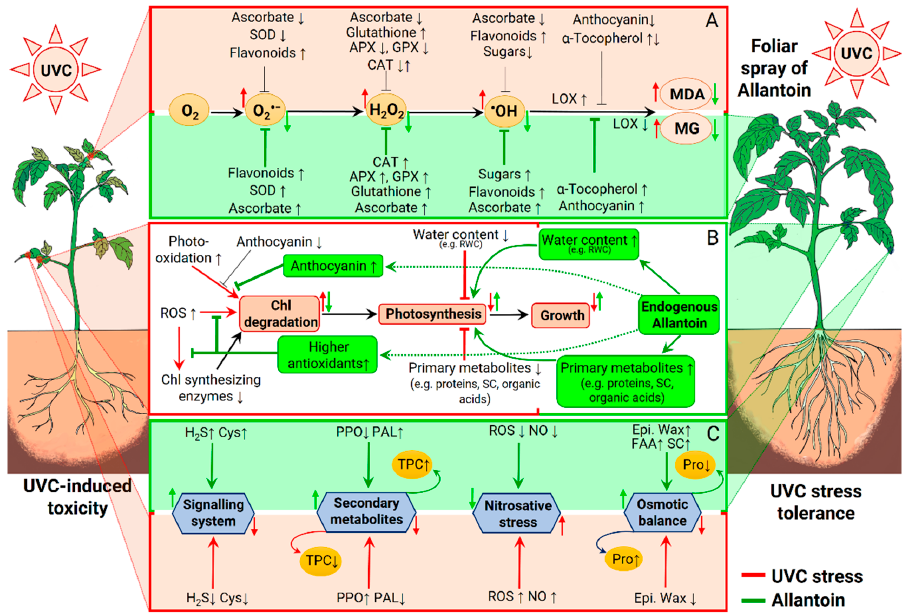
Figure 7. Particularly, AT-induced UVC stress tolerance could be attributed to (i) improve- ment of plant water retention via regulation of osmolytes, (ii) protection of photosynthetic pigments, (iii) efficient activity of enzymatic antioxidants to reduce ROS-induced mem- brane destruction, and (iv) accumulation of non-enzymatic antioxidants and secondary metabolites and its biosynthetic enzymes. Our findings suggest that the potential role of AT is effective in UV stress mitigation in tomato hybrid cultivar “F1-841” if we pretreat the plants. Further investigation, at the genetic and molecular level and field condition, is urgent to reveal the potentiality of AT-induced UVC stress mitigation in other varieties of tomato plants and perhaps in other crops. Plants 2021 , 10 , x FOR PEER REVIEW